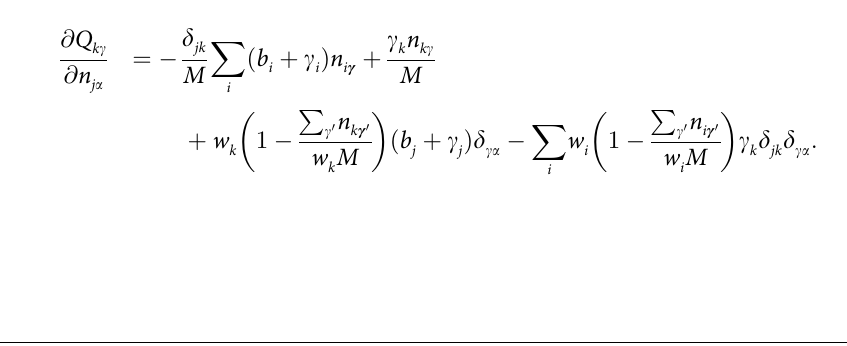
Fig 6. Empirical demonstration that the low-density coefficient matrix M numerically calculate the eigenvalues of the matrix M uniform distribution in [0, 10). Across 50000 samples shown, we find that only the largest eigenvalue of this matrix is positive and all the other eigenvalues are always negative.